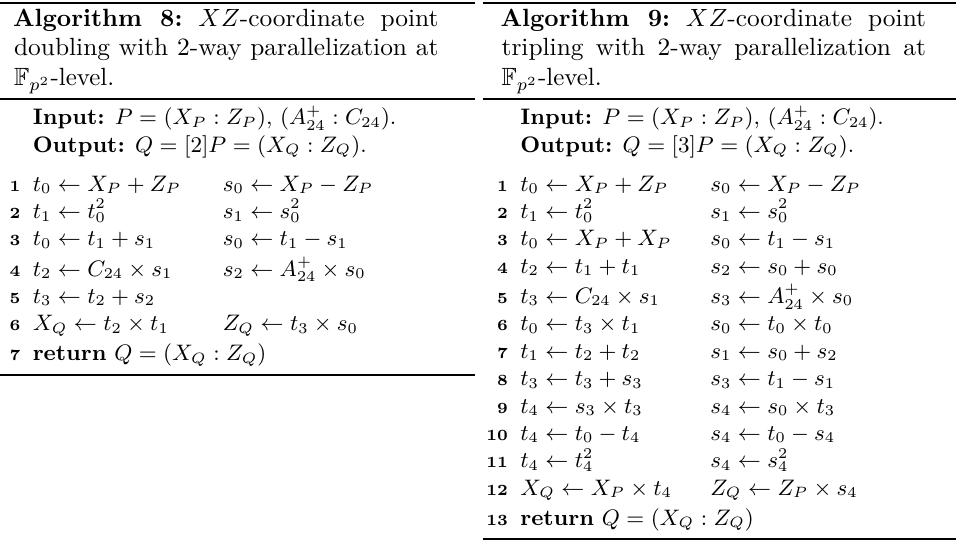
Algorithm 9: XZ -coordinate point tripling with 2-way parallelization at F p 2